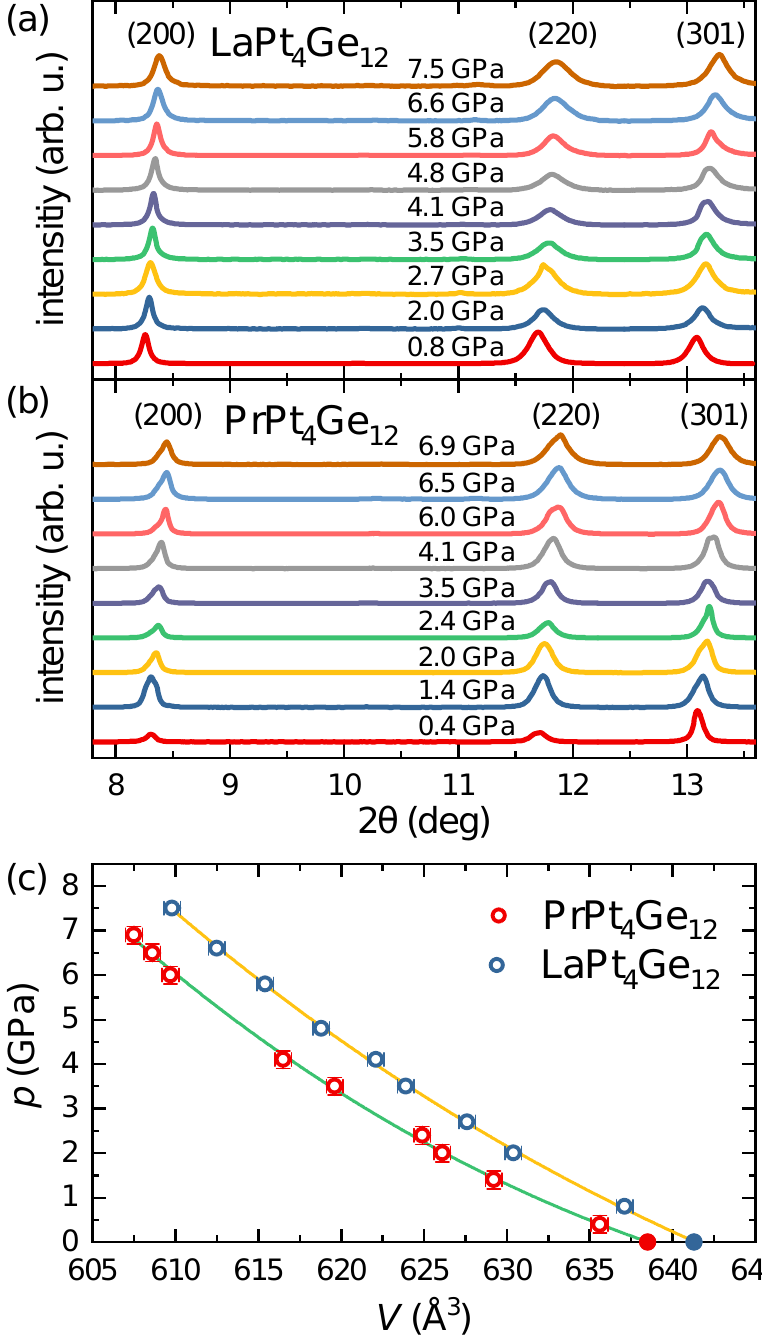
Figure 3. Normalized XRD data for different pressure values of ( a ) LaPt 4 Ge 12 and ( b ) PrPt 4 Ge 12 taken at room temperature. ( c ) Applied pressure plotted versus the unit-cell volume. The solid lines correspond to fits of the Birch-Murnaghan equation of state to the data of LaPt 4 Ge 12 and PtPt 4 Ge 12 . The data points at p = 0 (solid symbols) have been taken from literature [28]. See text for details. The pressure dependence of the unit-cell volume obtained from the experimental lattice parameters of LaPt 4 Ge 12 and PrPt 4 Ge 12 were fitted using the Birch-Murnaghan equation of